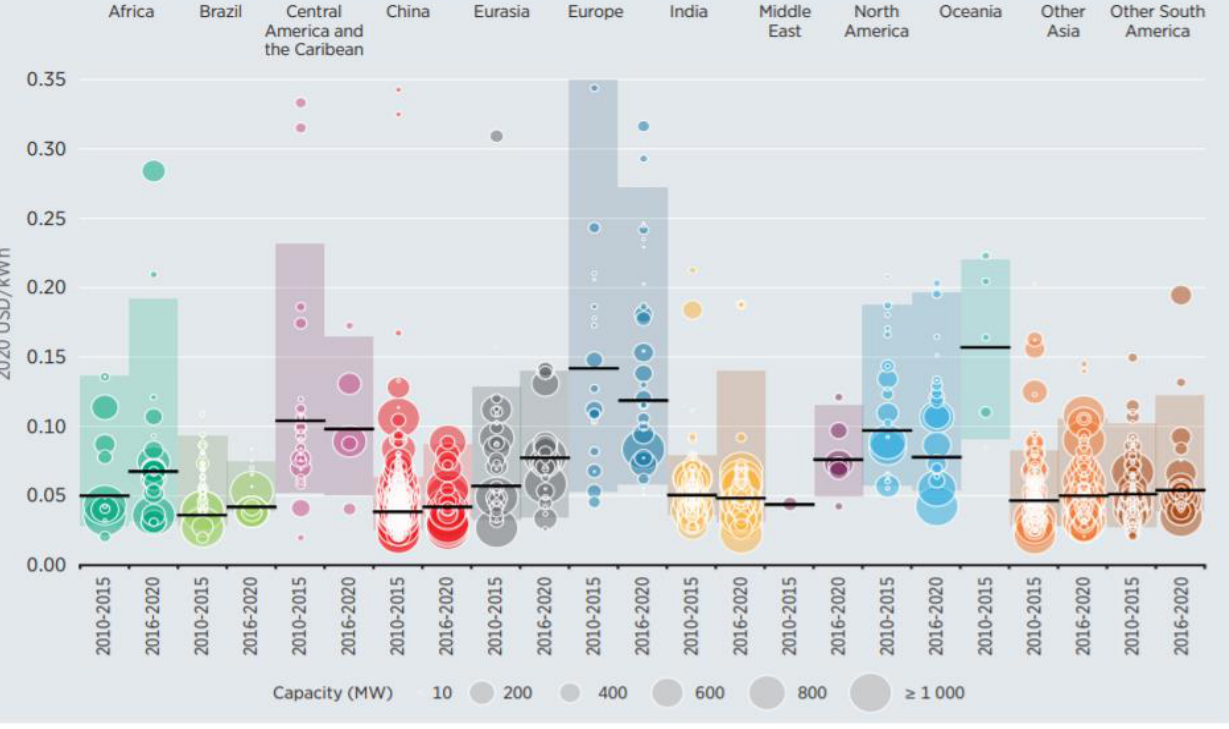
Figure 12. Total installed cost for large hydropower plants by country/region, 2010–2020 [82].